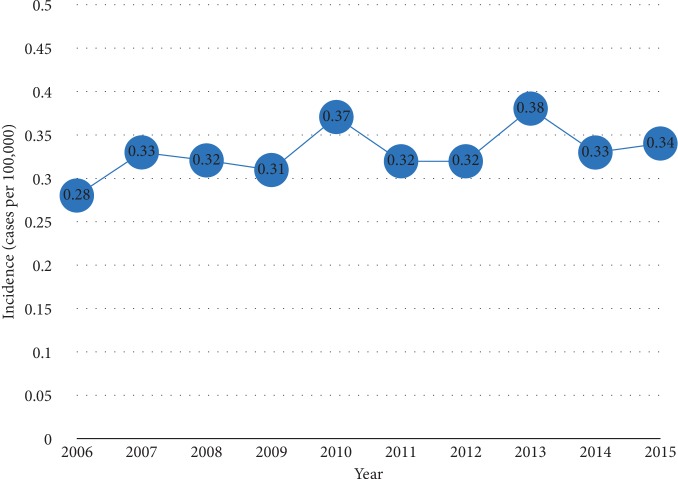
Incidence trends for NPC, 2006–2015.